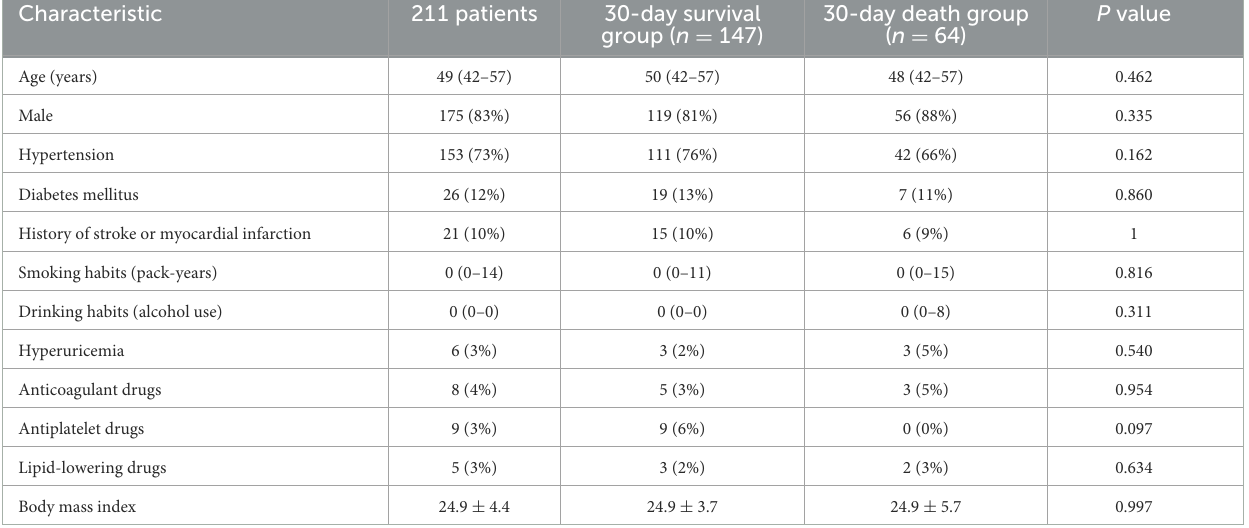
TABLE 1 General characteristics of study